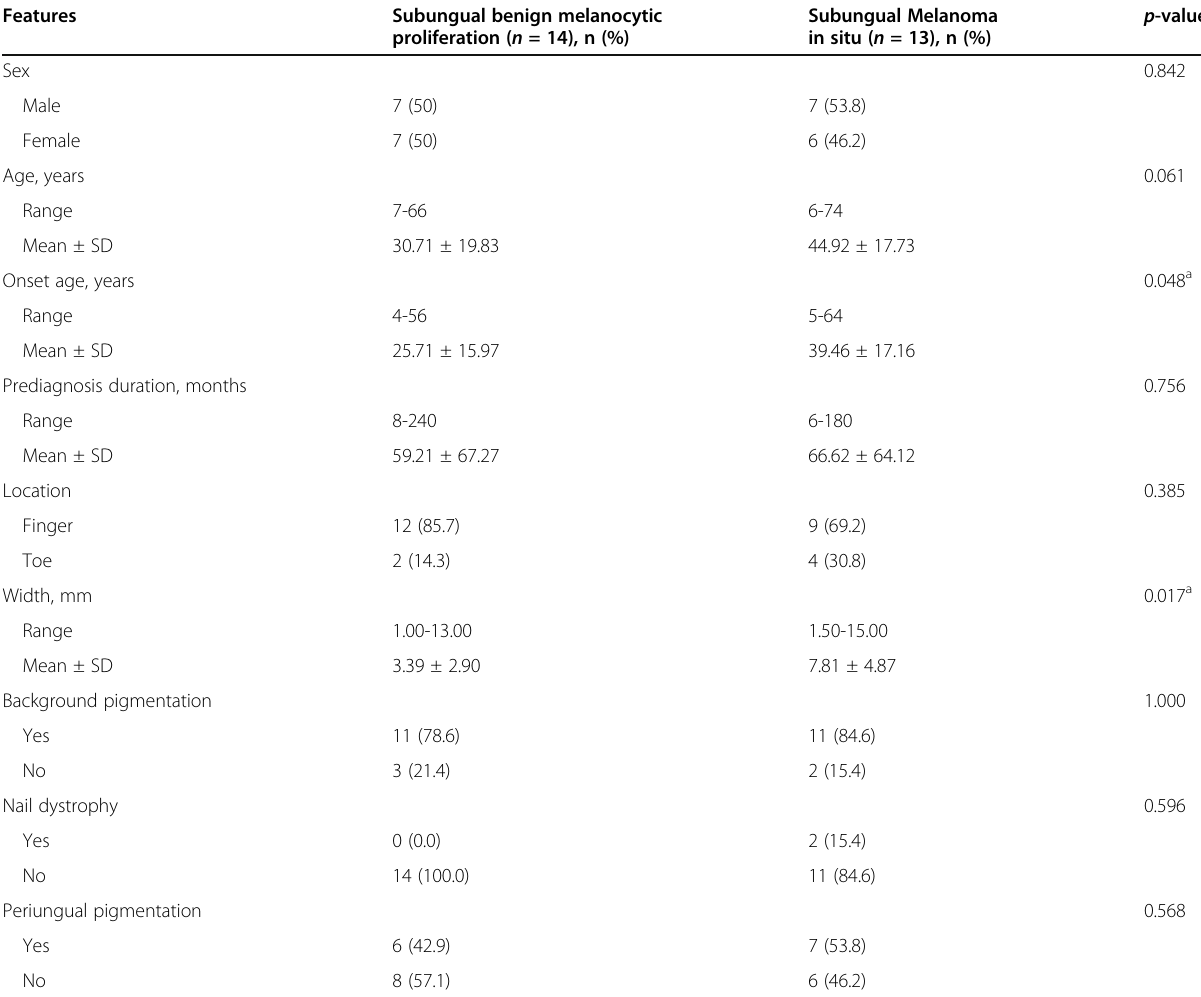
Table 1 Clinical features of subungual benign melanocytic proliferation and subungual melanoma in situ